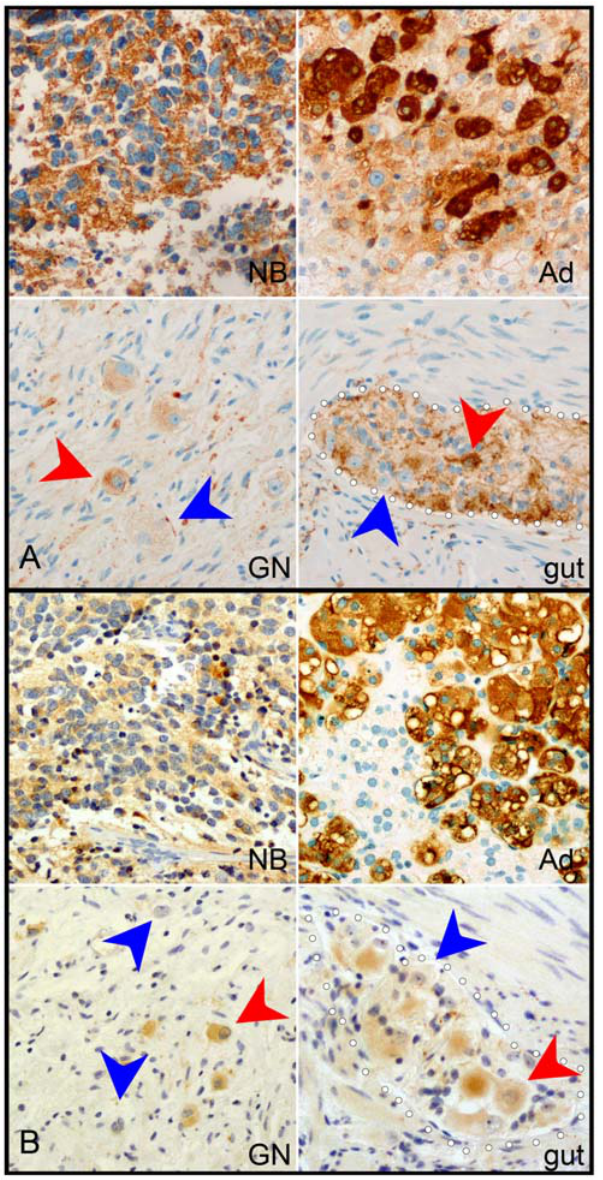
Figure 1. Adrenergic markers CHGA (A) and DBH (B) were expressed strongly in NB and weakly in GN. For each of these genes, immunocytochemistry produced intense labeling of NB, resembling the staining pattern of adrenal medulla (Ad). In contrast, in both GN and enteric ganglia, labeling was less intense, and was limited to a subset of neurons (red arrowheads), leaving other neurons unlabelled (blue arrowheads). Dotted white lines highlight the margins of the enteric ganglia.